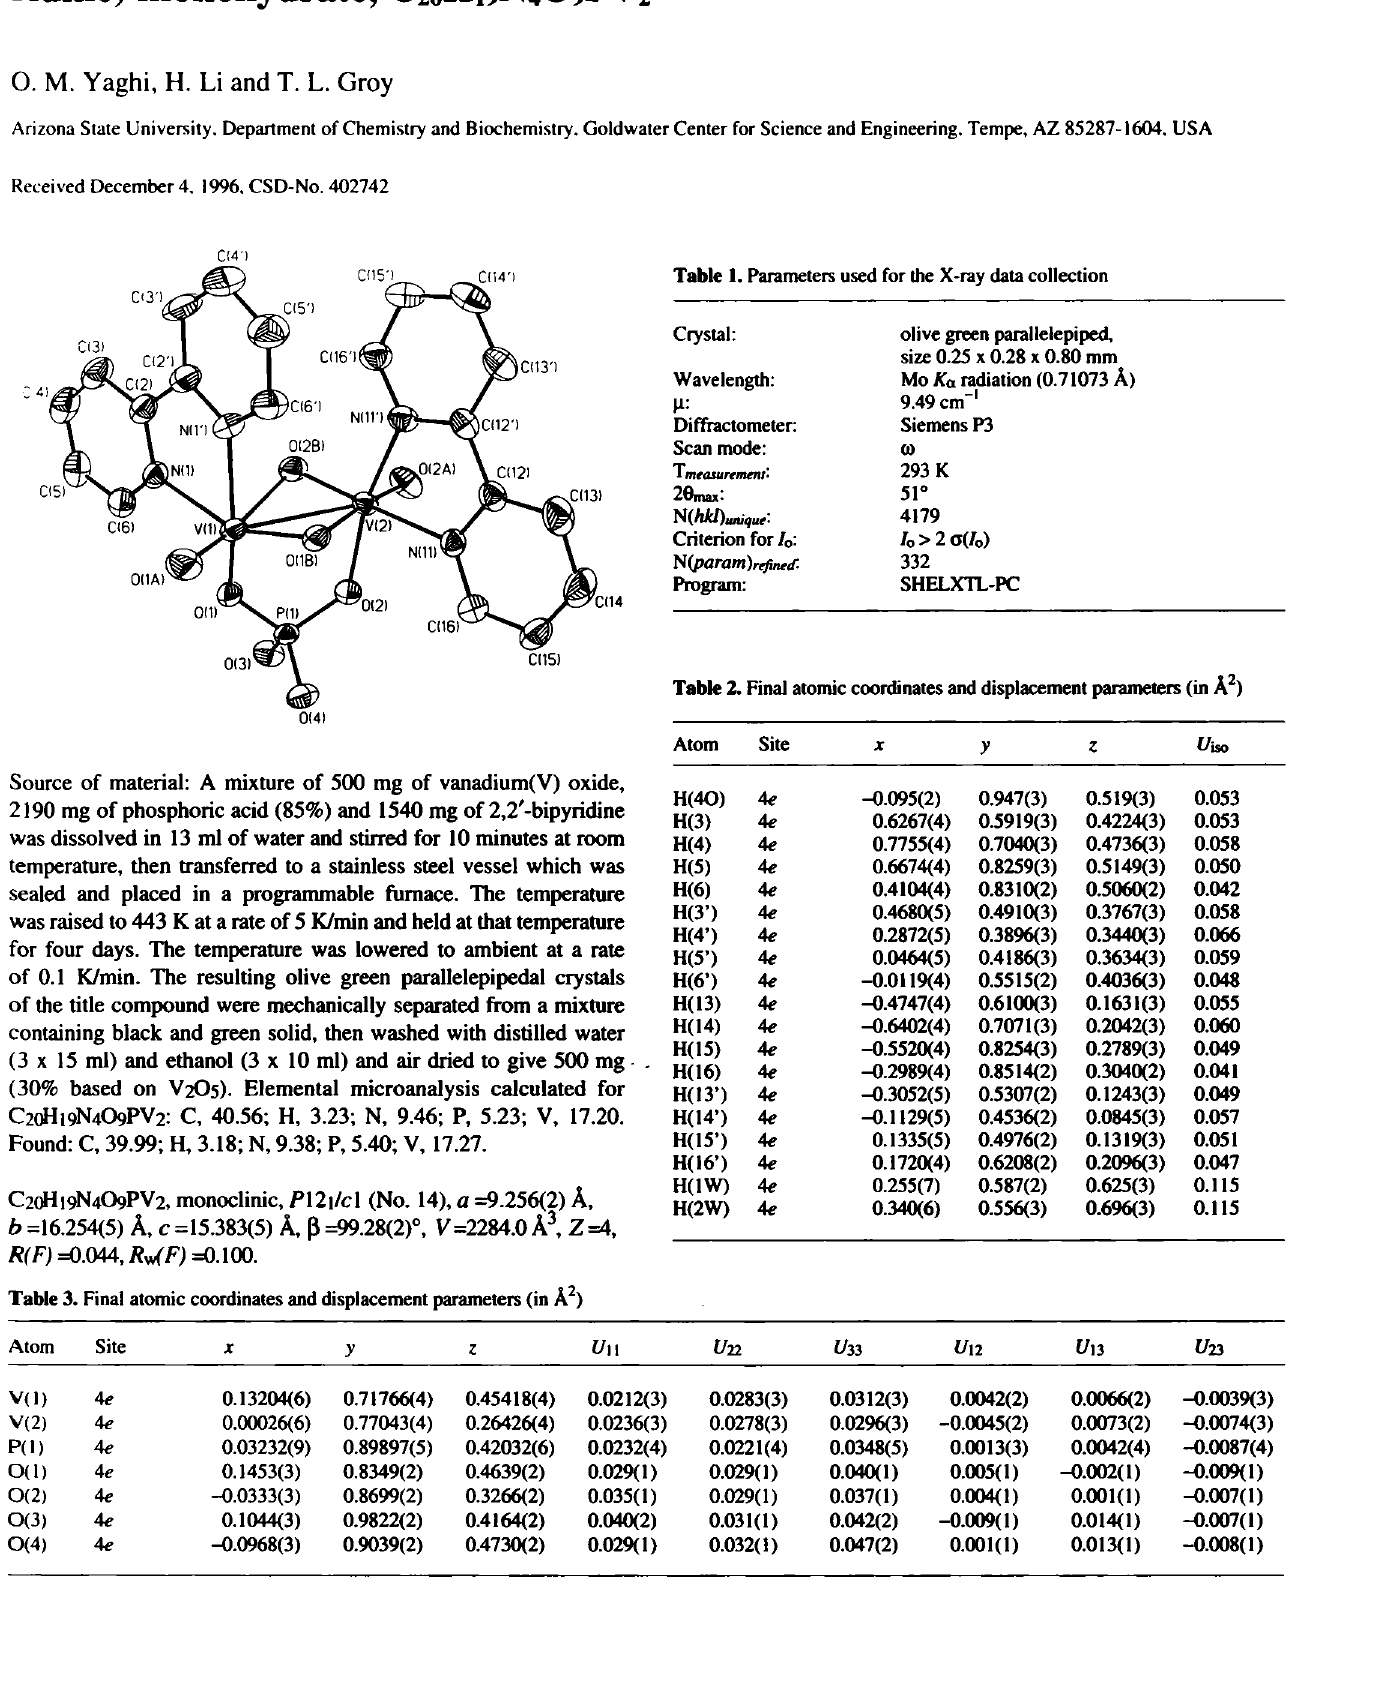
Table 3. Final atomic coordinates and displacement parameters (in Â 2 )